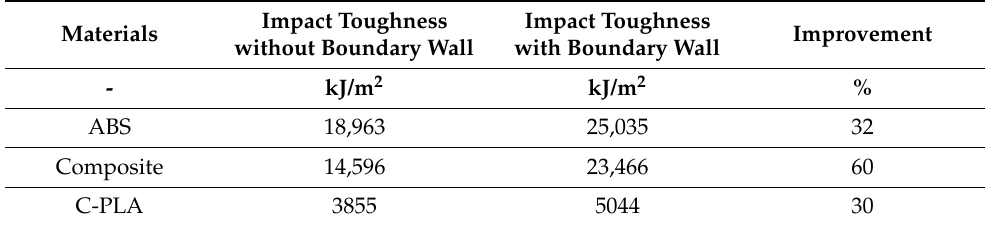
Figure 4. Boundary wall effect on impact toughness considering various materials: ABS, C-PLA, and hybrid laminar composite: each test was repeated twice. Table 2. Impact toughness of samples made with and without boundary wall.